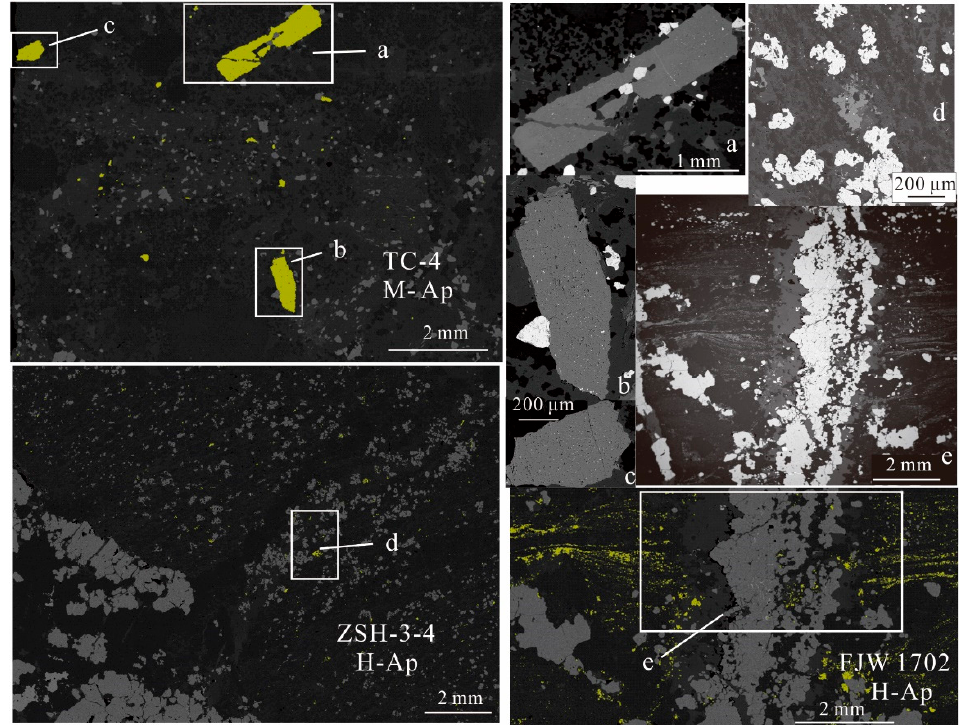
Figure 4. Different stages of fluid filling in the Dexing samples and TIMA mapping of the apatite. Apatite grains a, b and c are considered to form in the magmatic process from Tongchang open pit (TC-4); d, e are considered to form in the hydrothermal process from Fujiawu wall rock (FJW-1702) (M: magmatic; H: hydrothermal).